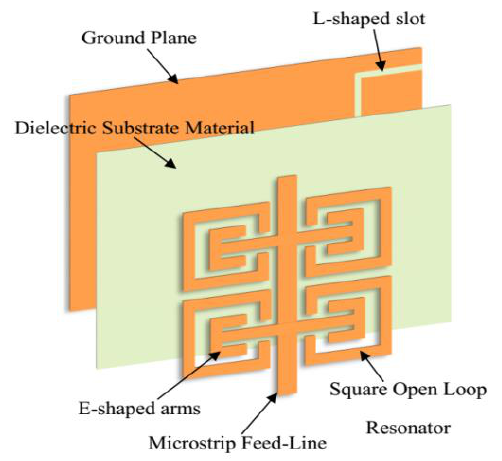
Figure 2. Four-pole band-pass filter structure layout.